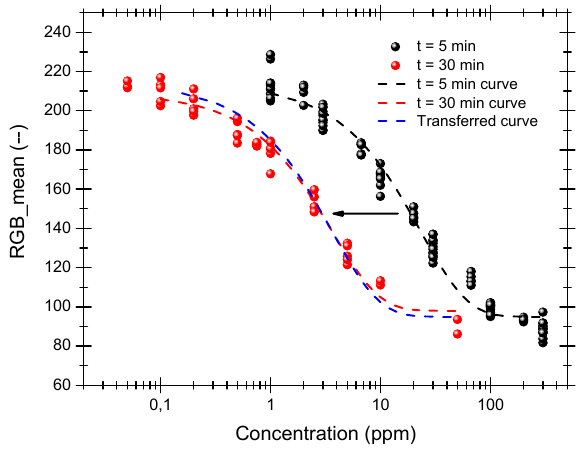
Figure 2. Summary of the responses to NO 2 , recorded from the RGB signal in experiments lasting 5 min and 30 min. Just by changing the exposure time, the same gas-sensitive pads can be used to monitor different NO 2 concentration ranges. Fitting curves demonstrate the transferability of the calibration